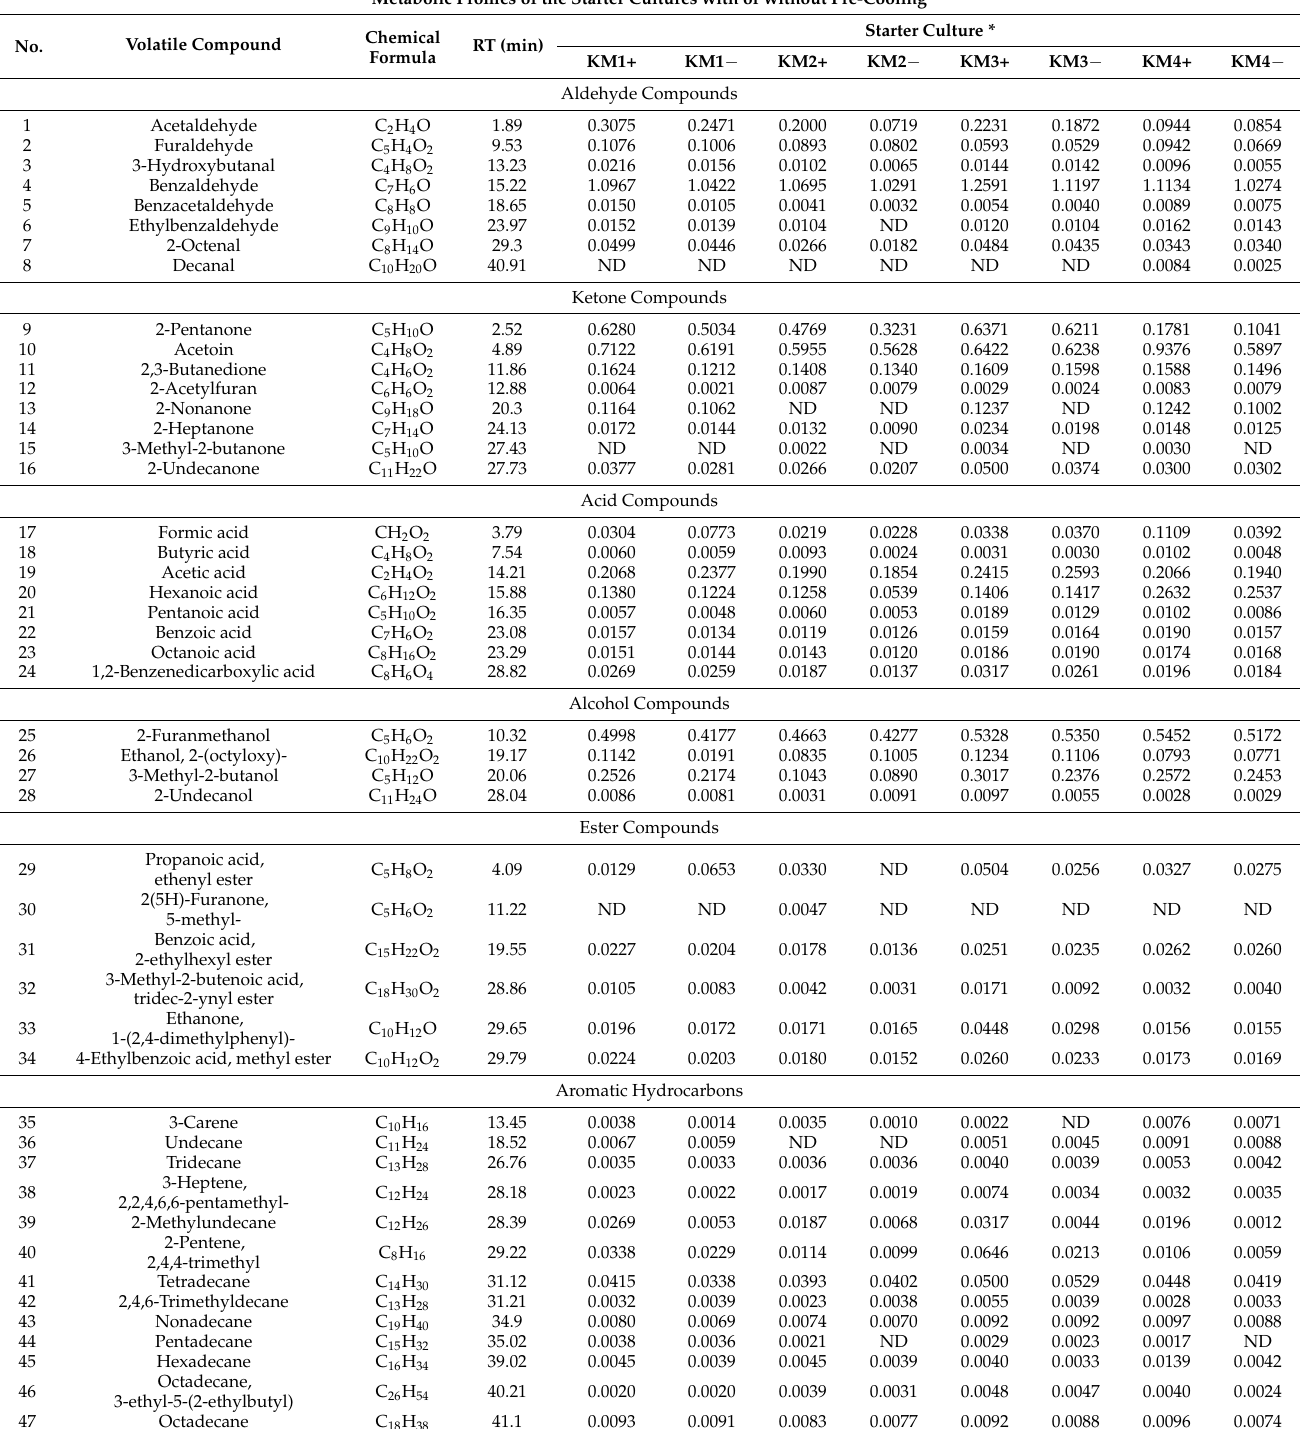
Table 4. Influence of the pre-cooling process on the metabolic profiles of symbiotic starter cultures KM1, KM2, KM3, and